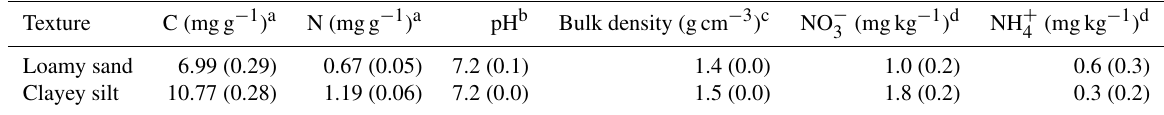
and NH + , n = 3) of both soils in 0–10cm depth after field sampling. 3 4 (mgkg − 1 ) d 3